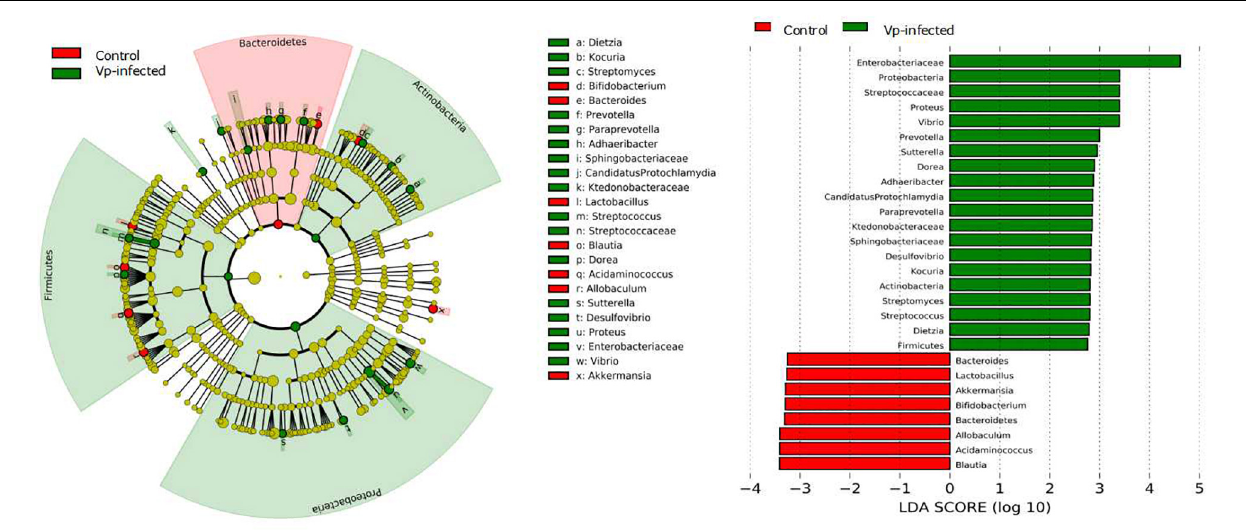
FIGURE 5 | Identification of significant differences in bacterial taxa between Vp-infected and control groups. Cladogram shows the differences and phylogenic location. In each section, the diameter of the circle is proportional to the abundance of the taxon. Ileum microbial communities from Vp-infected and control mice were compared using LEfSe (red = taxon significantly enriched in control; green = taxon significantly enriched in Vp-infected; yellow = not-significant). Histogram of the LDA scores computed for features differentially abundant between the Vp-infected and control groups. LEfSe scores represent the degree of consistent difference in relative abundance between features in two groups of analyzed microbial communities. The clades of the histogram identify statistical and biological differences between the communities. Taxonomic groups showing LDA scores > 2.0 with p <